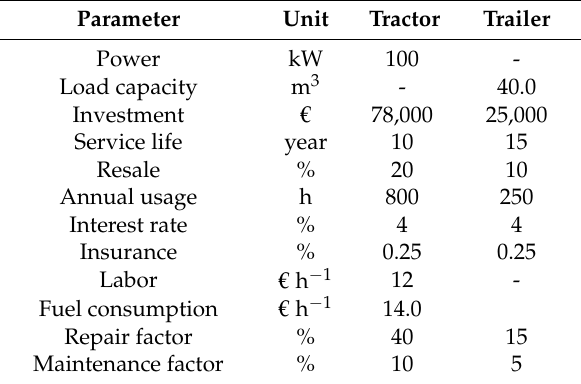
Table 4. Transport cost data.